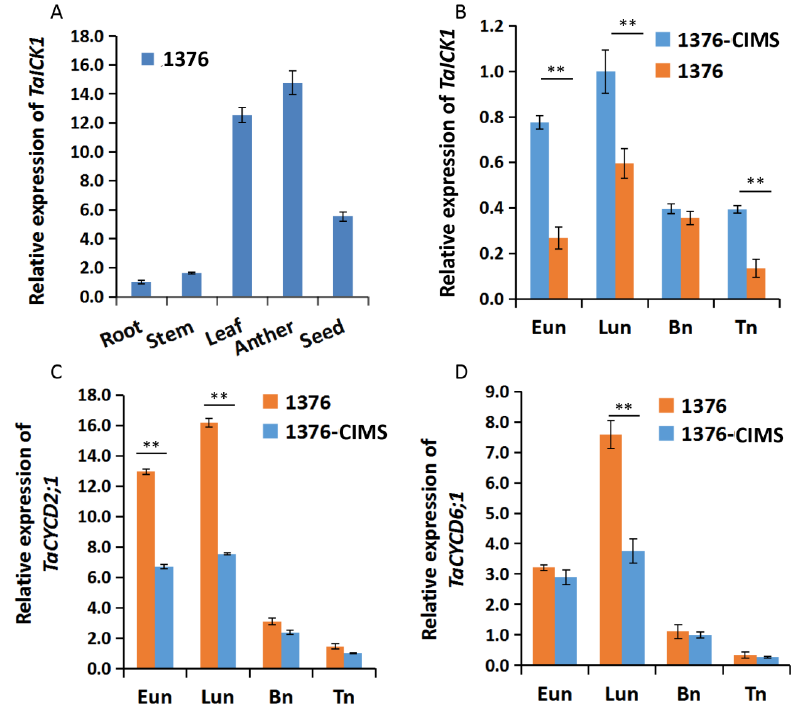
Figure 5. The expression patterns of TaICK1 . ( A ) The expression pattern in various tissues of XN1376. ( B ) The expression levels of TaICK1 in XN1376-CIMS and XN1376 at different stages of anther development. ( C ) The expression levels of TaCYCD2;1 in XN1376-CIMS and XN1376 at different stages of anther development. ( D ) The expression levels of TaCYCD6;1 in XN1376-CIMS and XN1376 at different stages of anther development. Data are presented as the means ± SD; mean and error bars indicate SD with three technical replicates and three independent biological replicates. The significance of differences was assessed using Student’s t-test. * p < 0.05, ** p < 0.01.